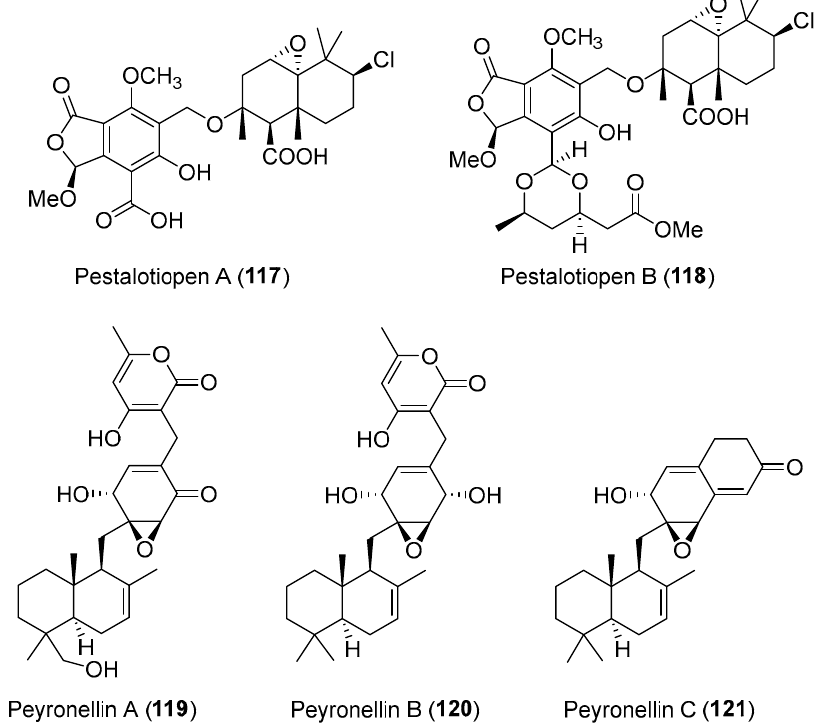
Figure 20. Structures of pestalotiopens A–B ( 117 – 118 ) and peyronellins A–C ( 119 – 121 ).